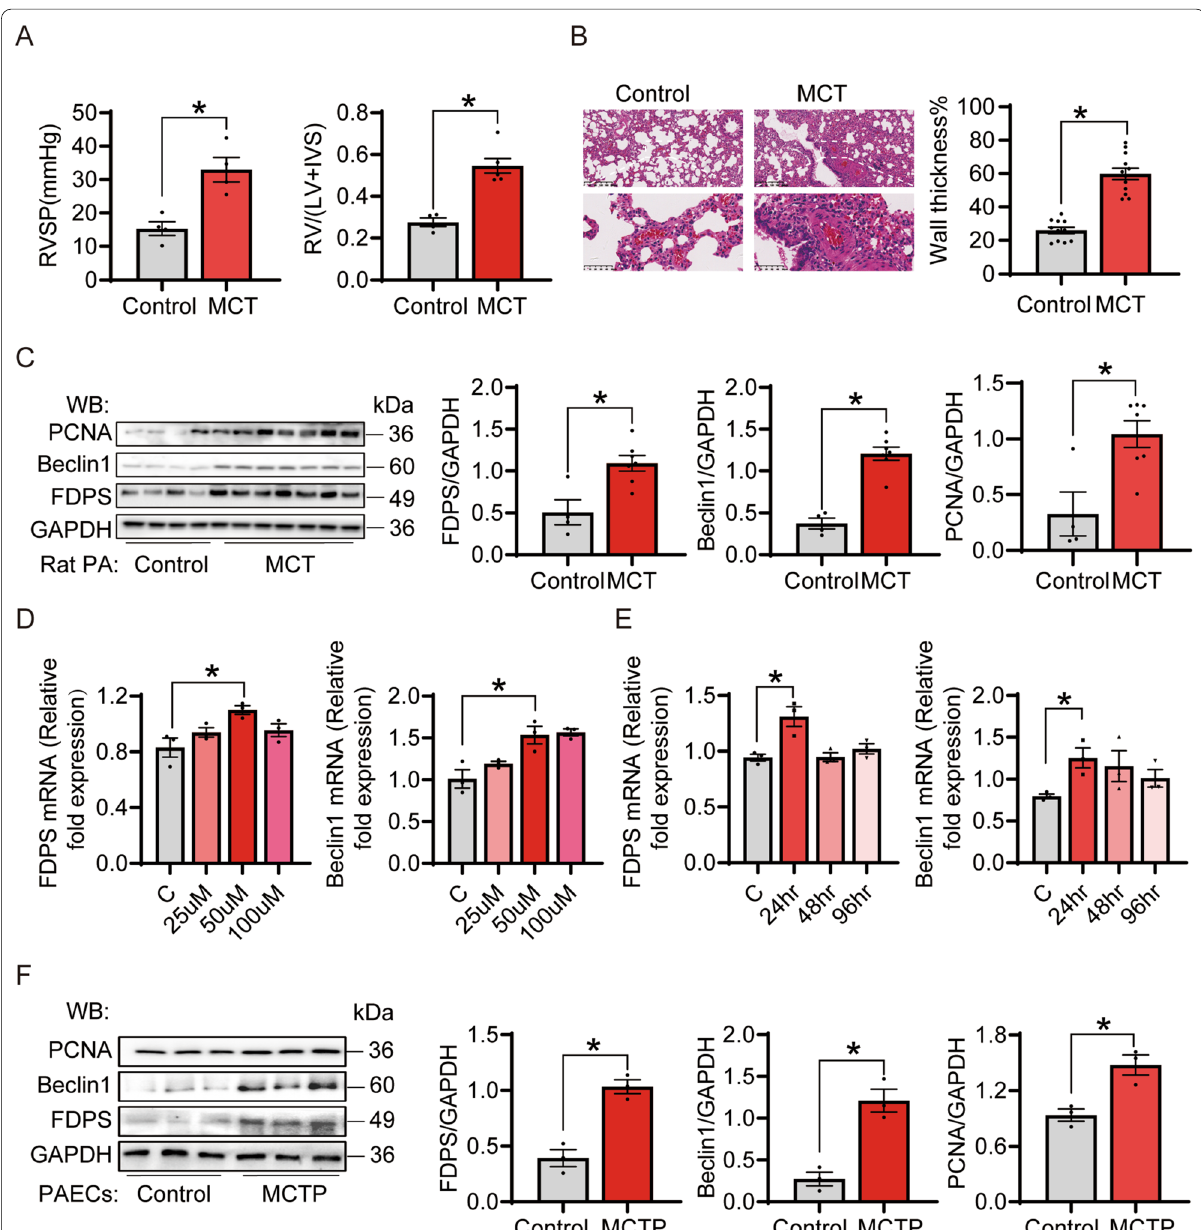
Fig. 1 PAH increased the expression of FDPS, PCNA and Beclin1 in vivo and in vitro. A RVSP and RV/(LV n 4–6 per group. B Hematoxylin and eosin staining of lung tissues. The index of wall thickness was calculated and showed in right. Scale = bar 50 μm. n 11–12 per group. C Immunoblot analysis for FDPS, PCNA and Beclin1 in control and MCT-induced PAH rats. GAPDH was used as = = internal reference. n 4–7 per group. D The mRNA level of FDPS and Beclin1 in PAECs after different concentration of MCTP treatment for 24 h = was detected. n 3 per group. E The mRNA level of FDPS and Beclin1 in PAECs after 50 μm MCTP treatment for different times was detected. = Quantitative RT PCR (qRT-PCR) was conducted to measure mRNA level changes, with 18S as an internal control. n analysis for FDPS, PCNA and Beclin1 in the control and MCTP treatment PAECs. GAPDH was used as internal reference. n expressed as the mean SEM. All experiments were independently replicated in triplicate. *P < ±